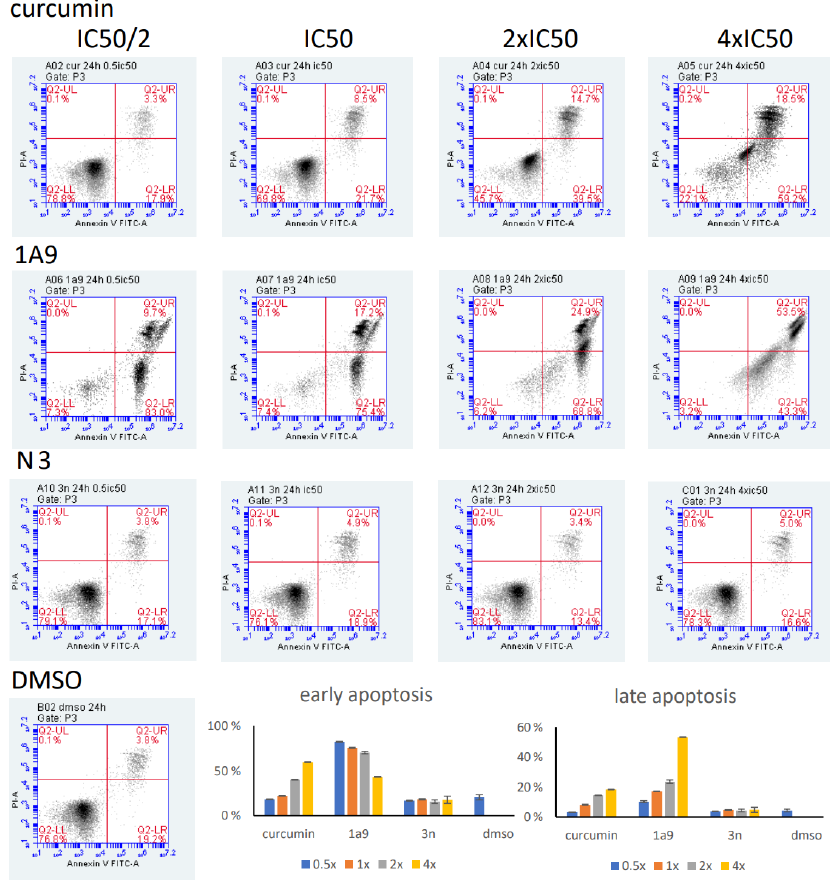
Figure 8. Induction of apoptosis in CCRF ‐ CEM cells upon exposure at 37 °C for 24 h with curcumin, N ‐ (3 ‐ nitrophenylpyrazole) curcumin, and 1A9 as determined by the annexin V/propidium iodide assay and flow cytometry. Cells were incubated with 0.5 × , 1 × , 2 × , or 4 × IC 50 . DMSO was used as vehicle control. Mean ± SD of three independent measurements.